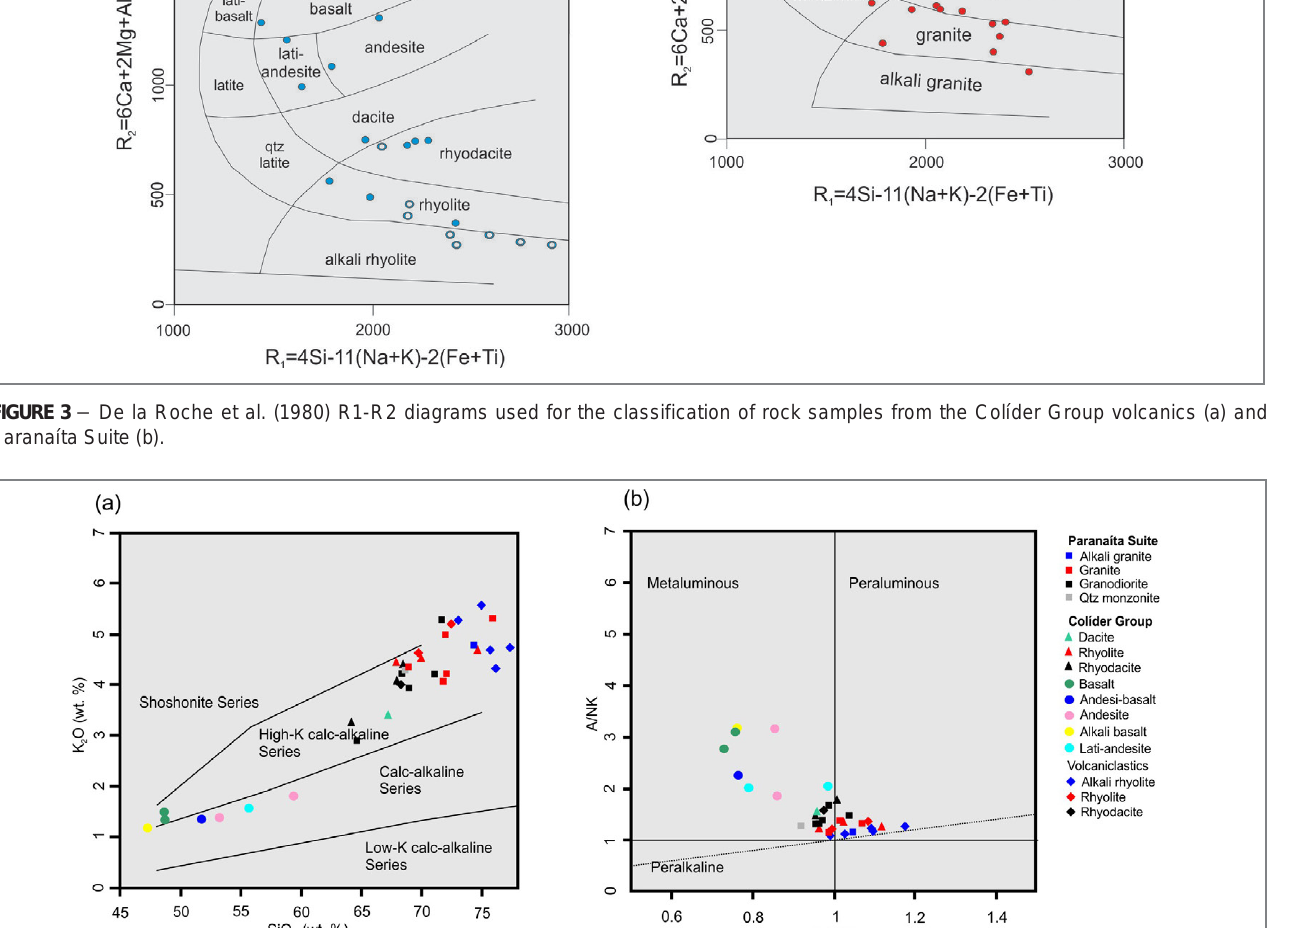
O /Na O+K2O (A/NK) versus Al 2 3 2